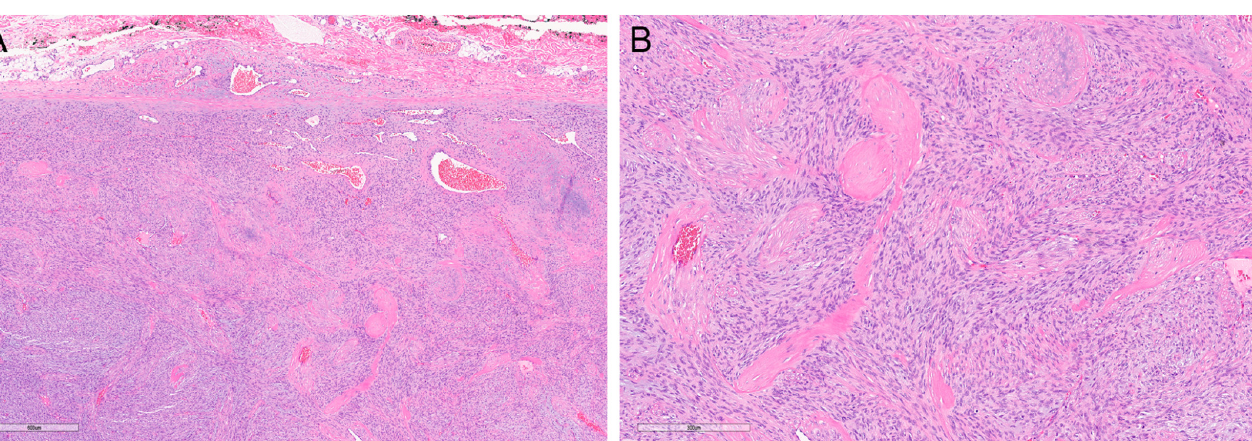
Figure 3. Pigmented DFSP (Bednar tumor). Occasionally, DFSP can show areas of melanocytes con- taining melanin pigments (( A ); magnification ×40 and ( B ); magnification ×200). The tumor otherwise shows characteristic features of DFSP. This feature has no prognostic importance.